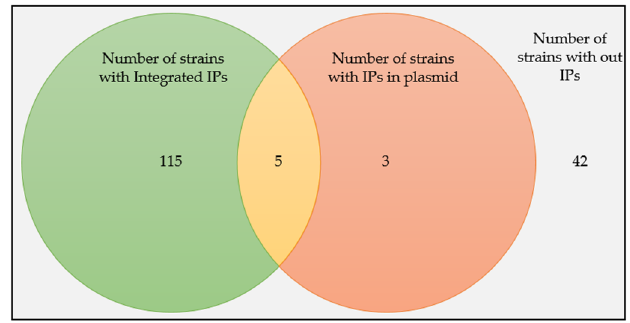
Figure 2. The prevalence of Ips in B. subtilis strains and their distributions as integrated or plasmid forms.